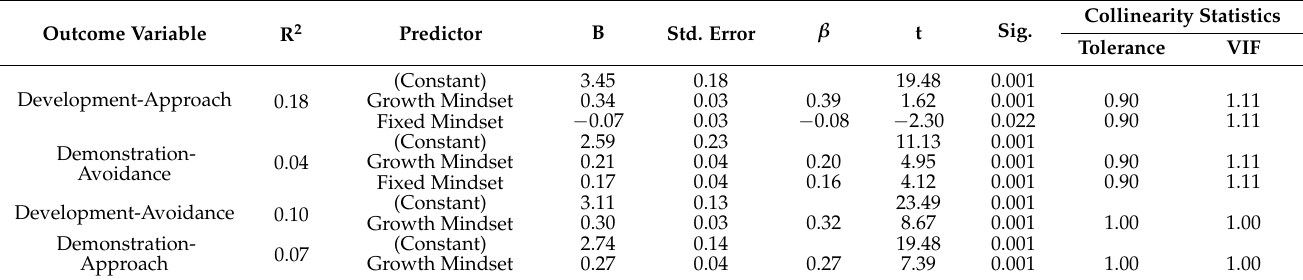
Table 5. Predictive Role of Chinese EFL Learners’ Mindsets on Achievement Goals.